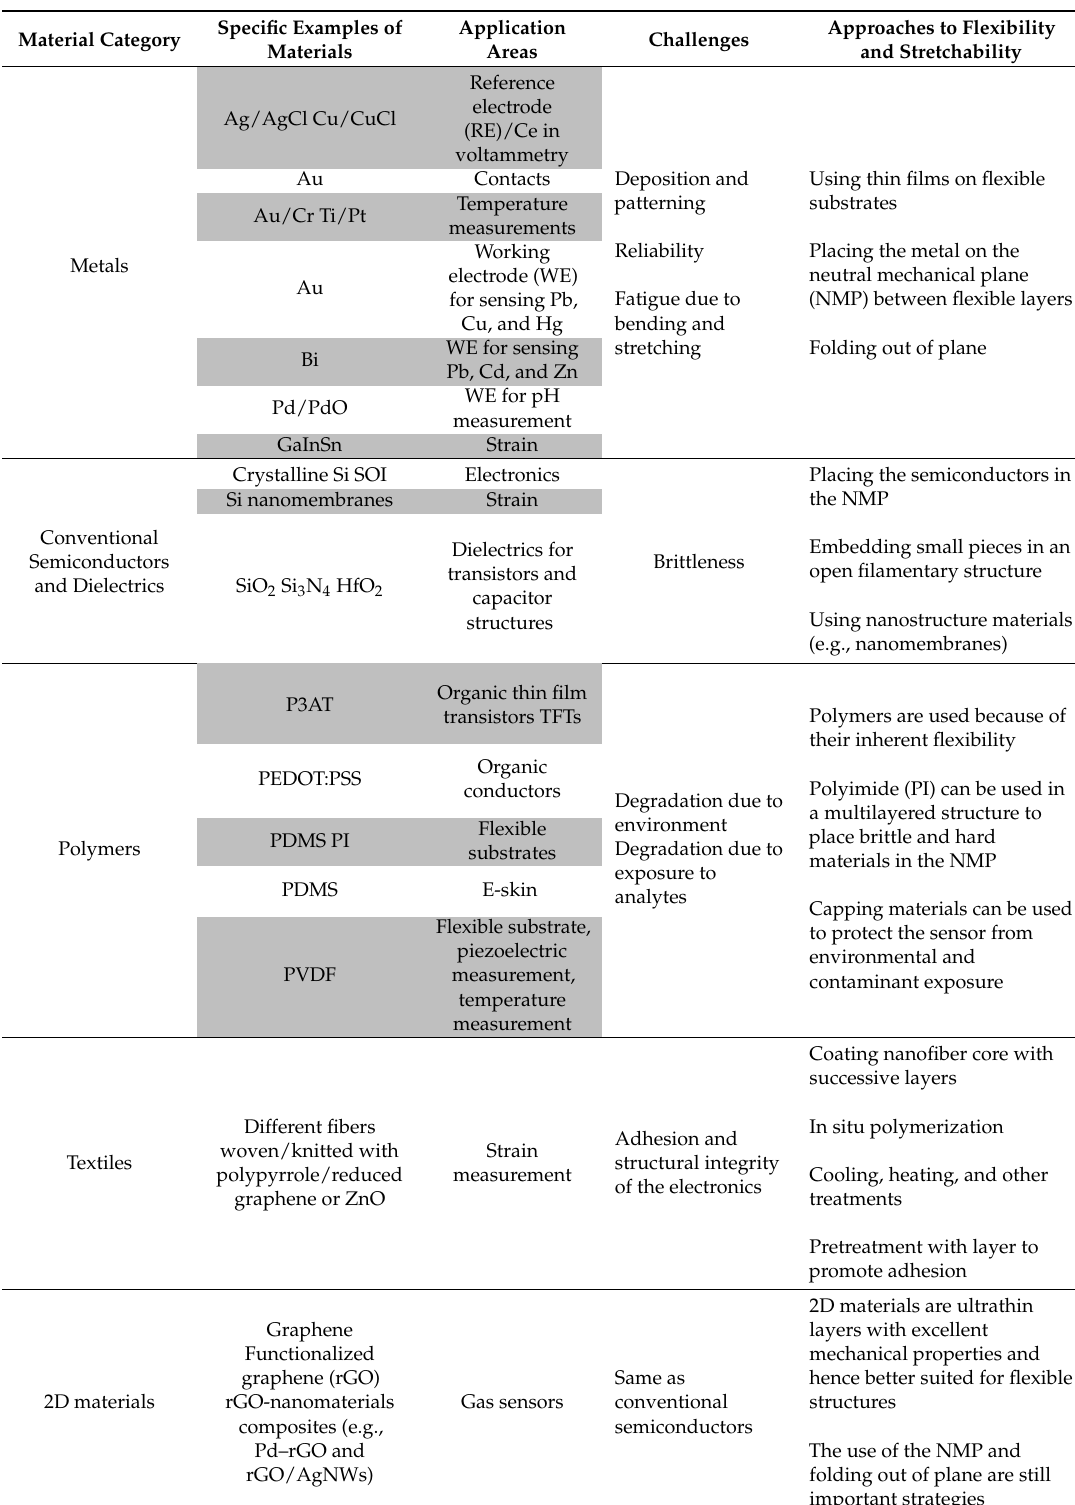
Table 1. Summary of the range of materials needed in the design of wearable sensors together with some of the most important strategies for wearability, flexibility, and